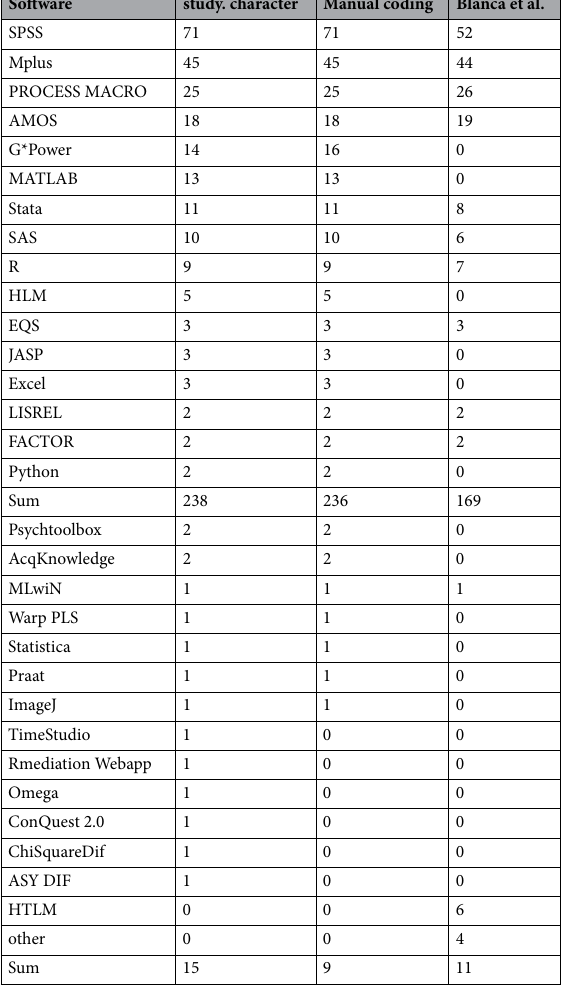
Table 12. Absolute frequencies of detected software solutions by study.character , the manually coded data, and the explicitly stated software solution used for the main analyis reported in Blanca et al.’s Table 7.